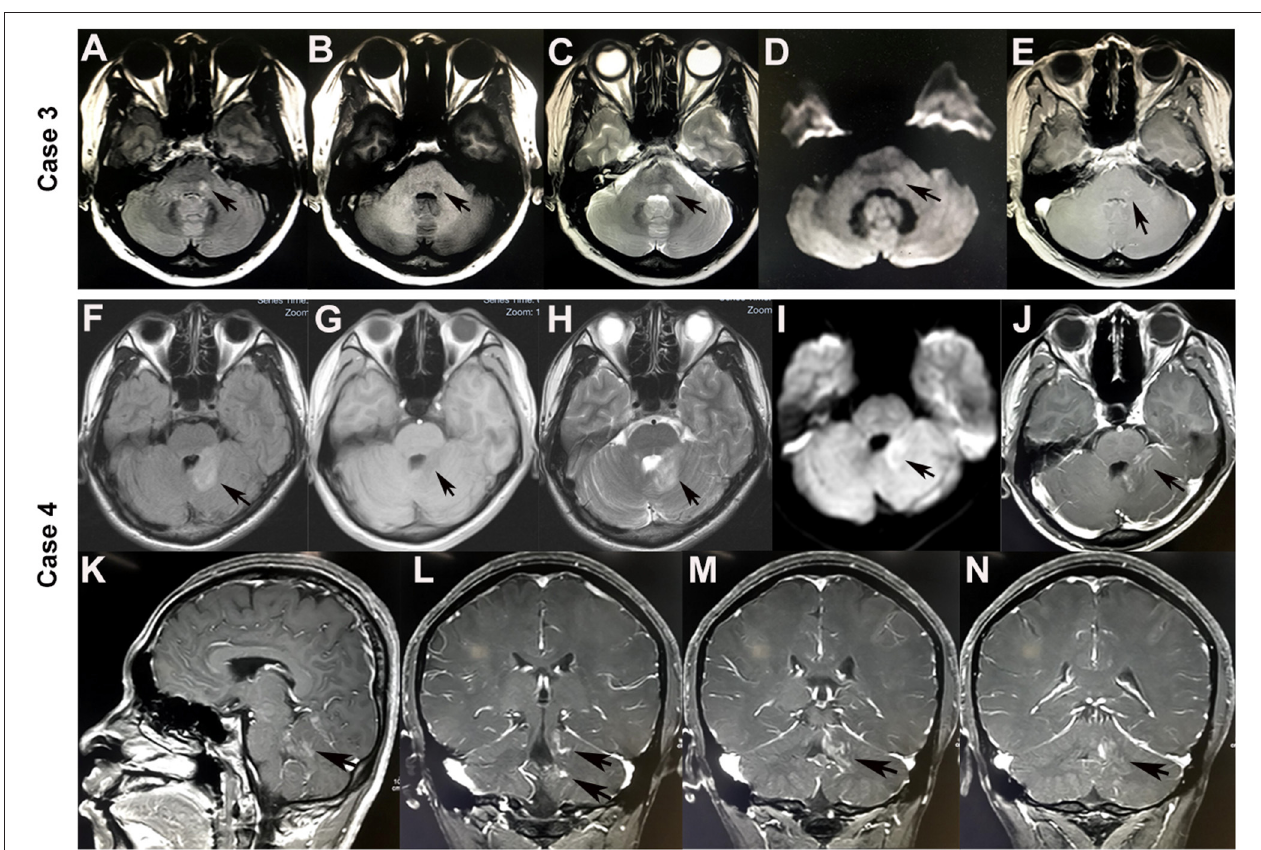
FIGURE 3 | Brain MRI of brainstem lesions in cases 3 and 4. A nodular hyperintense lesion in the left brachium pontis on FLAIR (A) , T2-weighted (C) , and diffusion-weighted (D) images (arrowheads). However, it was hypointense on the T1-weighted image (B) , and with a gadolinium-enhanced edge on the T1-weighted image (E) (arrowheads). Hyperintense lesions in the left brachium pontis, left cerebellar hemisphere, and cerebellar vermis on FLAIR (F) , T2-weighted (H) , and diffusion-weighted (I) images (arrowheads). However, it was hypointense on the T1-weighted image (G) , and with curvilinear post-gadolinium contrast enhancement on the T1-weighted image: axial (J) , sagittal (K) , and coronal (L–N) (arrowheads). the left-side limbs and was transferred to our